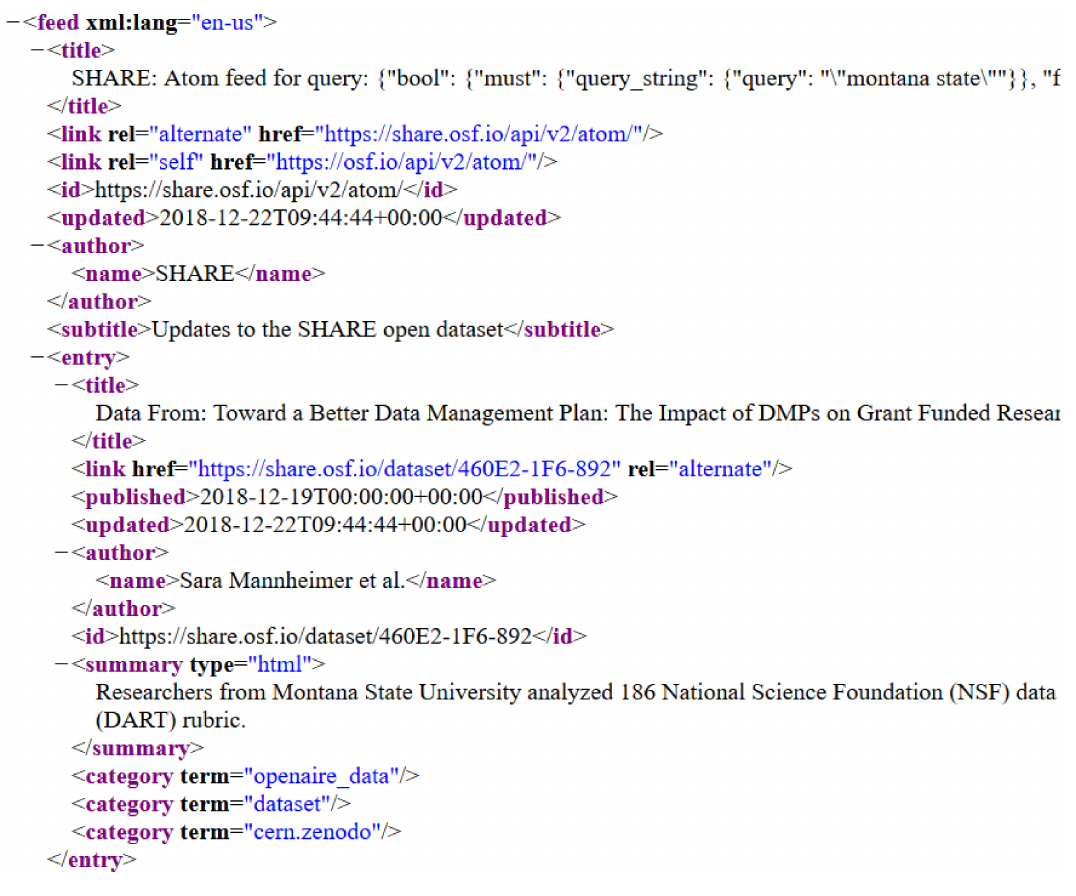
Figure 3. An excerpt of SHARE Atom